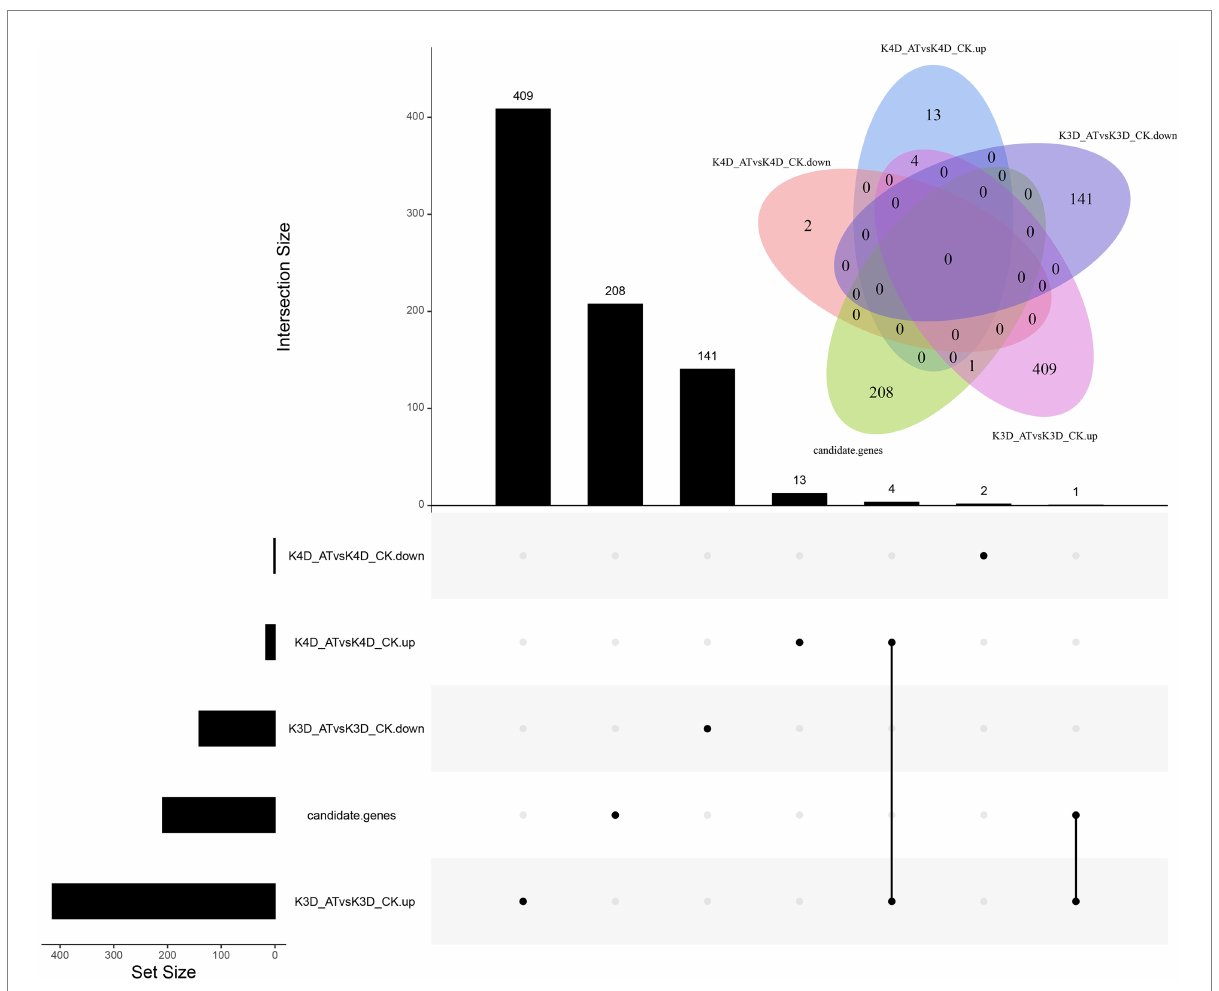
FIGURE 4 Venn diagram of DEGs distributed in maize inbred lines K10. The treatments included the normal control treatment for 3 and 4 days (CK), and the alkaline treatment for 3 and 4 days (AT). The alkaline treatment for 3 and 4 days are labeled “K3D_AT”and “K4D_AT,” respectively. The five treatment-line comparisons groups included the following: alkaline treatment for 3 days vs. normal control treatment for 3 days, upregulated expression (K3D_ATvsK3D_CK.up); alkaline treatment for 3 days vs. normal control treatment for 3 days, downregulated expression (K3D_ ATvsK3D_CK.down); alkaline treatment for 4 days vs. normal control treatment for 4 days, upregulated expression (K4D_ATvsK4D_CK.up); alkaline treatment for 4 days vs. normal control treatment for 4 days, downregulated expression (K4D_ATvsK4D_CK.down); and candidate